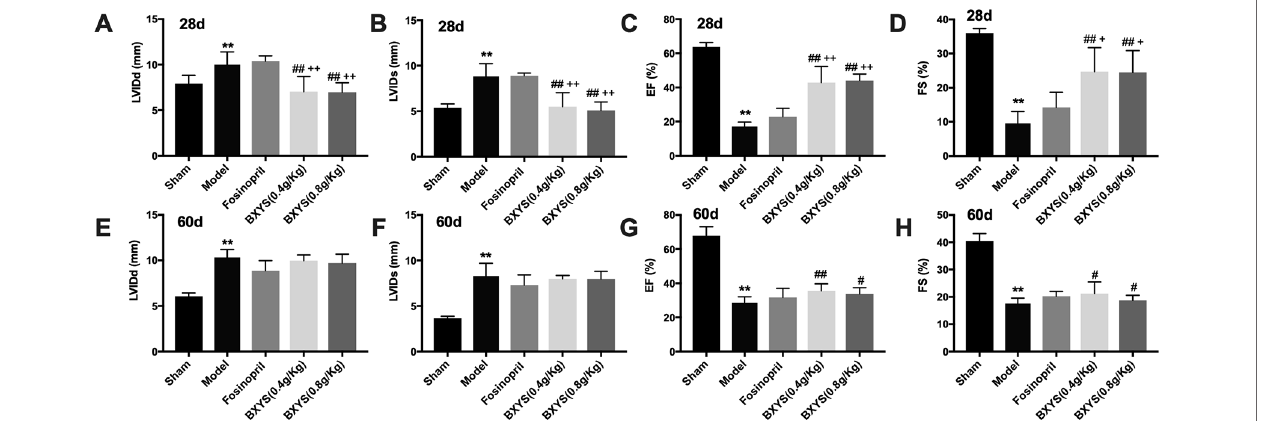
FIGURE 1 | Echocardiographic assessment after 28 days and 60 days of drug administration. Sham, sham group; Model, model group; Fosinopril, fosinopril group; BXYS (0.4g/kg), Buxin Yishen 0.4g/kg treated group; BXYS (0.8g/kg), Buxin Yishen 0.8g/kg treated group. **P < 0.01 vs. sham group. # P < 0.05, ## P < 0.01 vs. model group. + P < 0.05, ++ P < 0.01 vs. fosinopril group. (A) Left ventricular internal diameter at end-diastolic (LVIDd) after 28 days. (B) Left ventricular internal diameter at end-systolic (LVIDs) after 28 days. (C) Ejection fraction (EF) after 28 days. (D) Fractional shortening (FS) after 28 days. (E – H) LVIDd, LVIDs, EF, FS after 60 days of drug